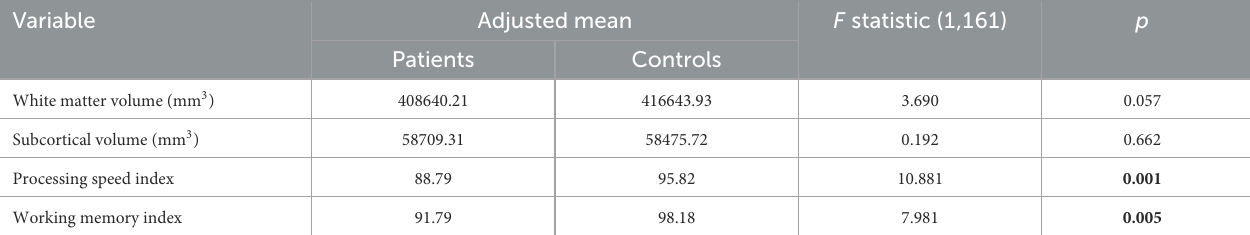
TABLE 2 Analysis of covariance (ANCOVA) for MRI and cognitive variable between SCA patients and controls. Variable